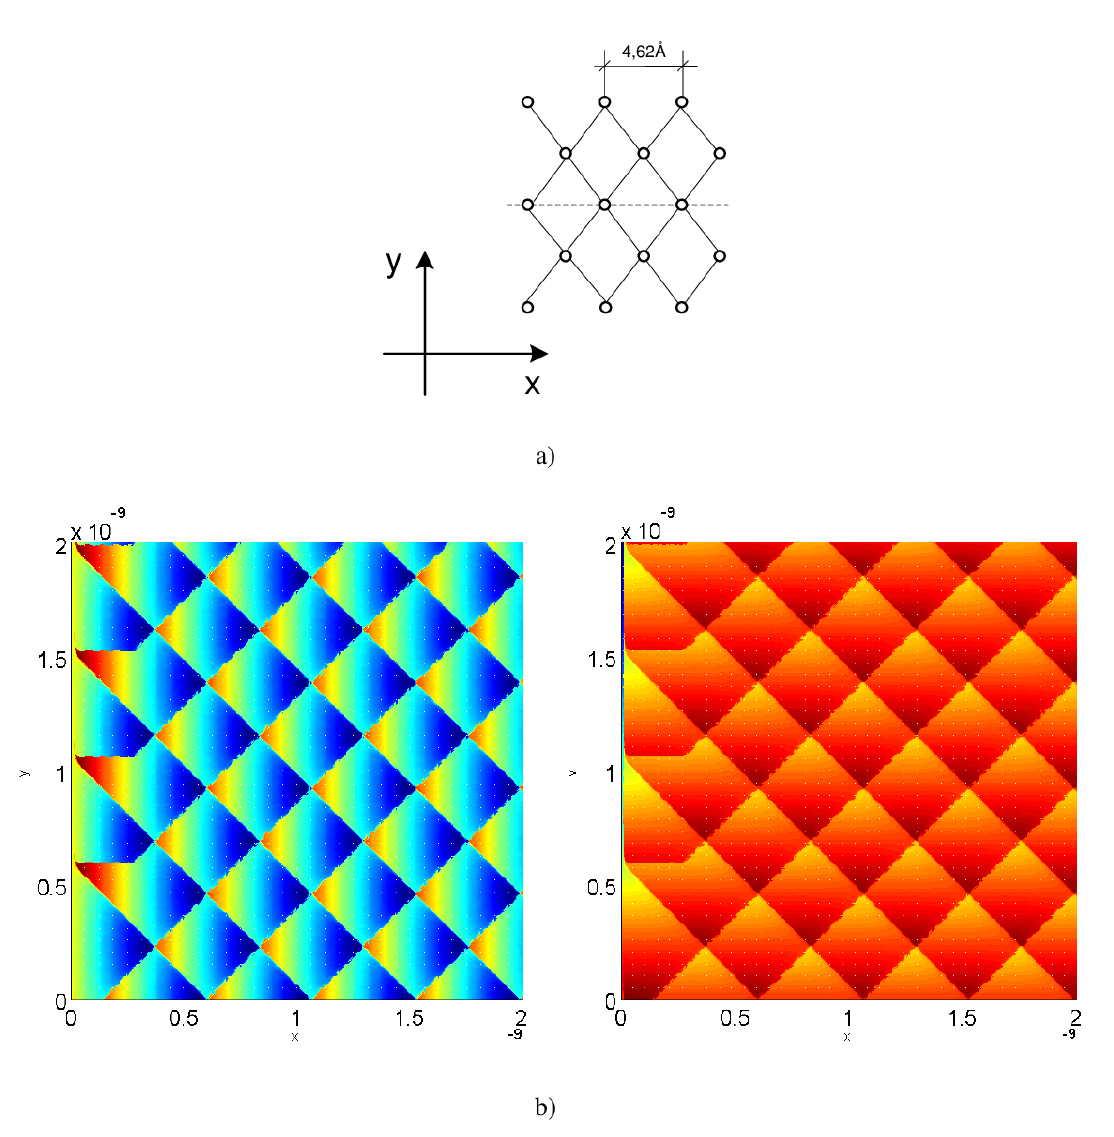
Figure 7 a) Position of the atoms in the NaF crystal net; b) Elastic force in the tip: F x in the left hand side and F y in the right hand